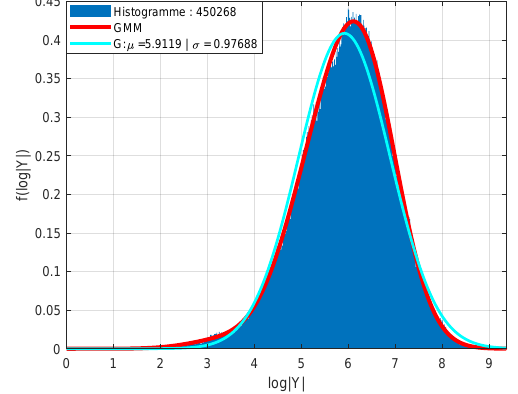
( b ) Adequacy to normal distribution (red) for healthy berries and comparison with gaussian mixture (teal)